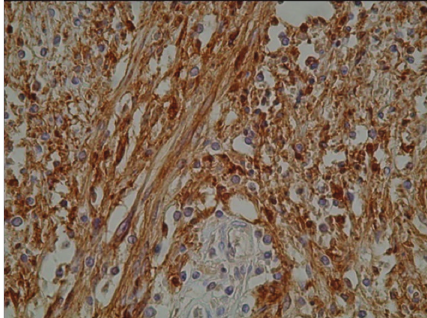
Figure 1: MRI: T1 low sign: L3 compaction.